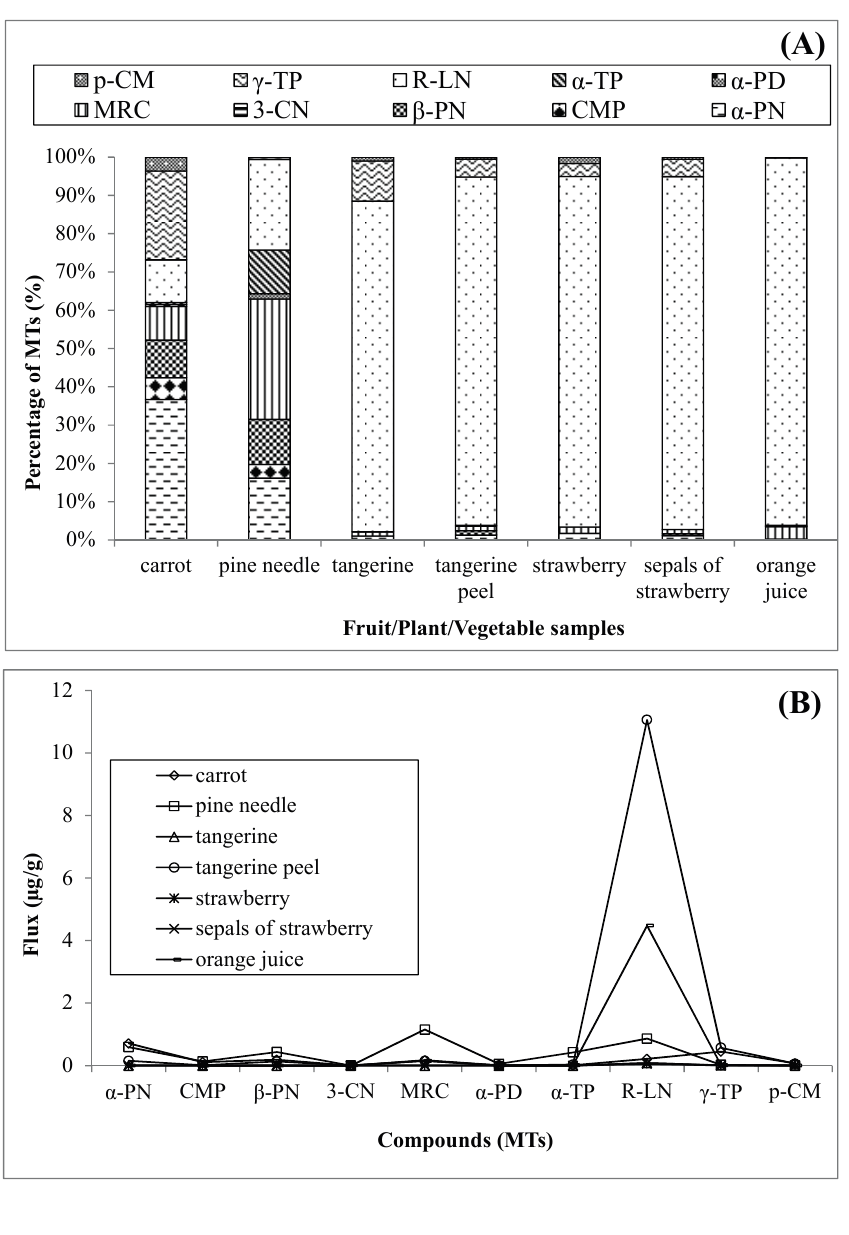
Figure 5. Emission of MTs from fruit/plant/vegetable (F/P/V) samples: ( A ) Relative composition (%) of MTs in collected headspace samples and ( B ) Emission (µg/g) patterns of MTs between different F/P/V